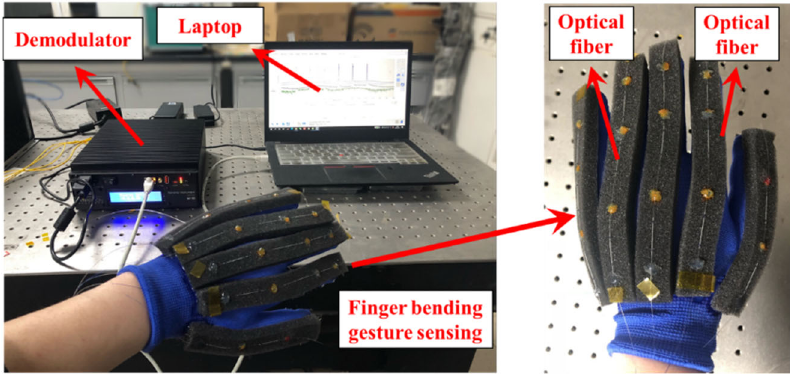
Figure 2. Fingers bending measured by FBGs.